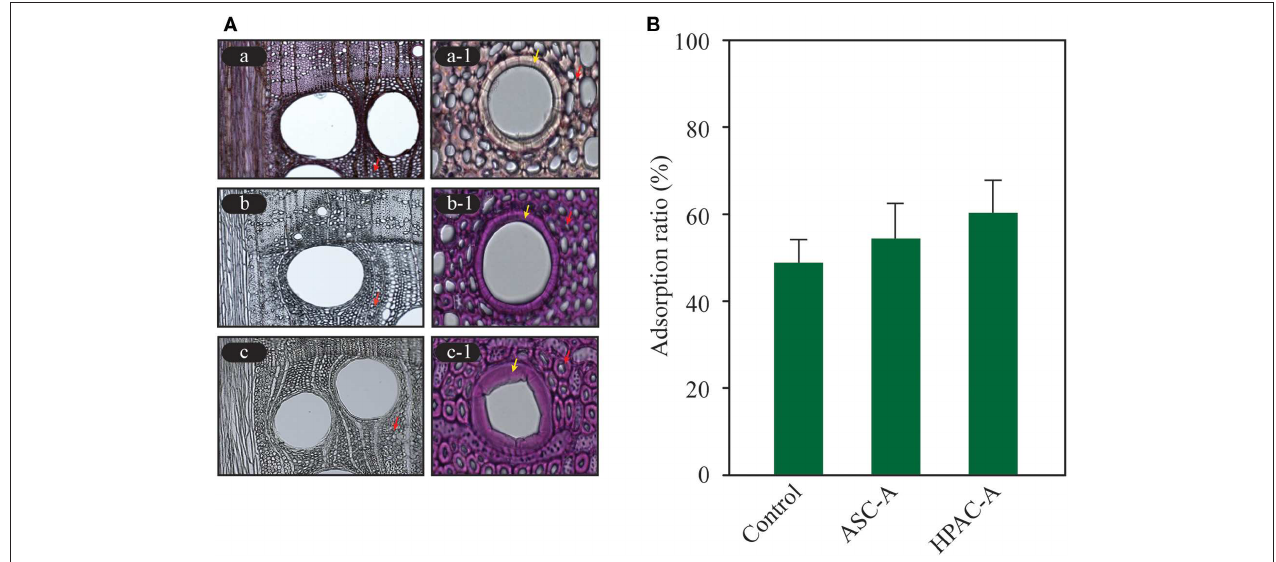
FIGURE 2 | Structural modification of cellulose. The modifications to ASC- and HPAC-pretreated oak and Avicel were determined using a light microscope and enzyme adsorption. (A) Significant cellulose swelling in the wood fibers (red arrow) and vessel elements (yellow arrow) was observed in the HPAC-pretreated oak compared with the ASC-pretreated oak. Lignin was not detected in b and c . a , control; b , ASC-pretreated; c , HPAC-pretreated. (B) Comparison of the cellulase adsorption. The control was Avicel that was not pretreated. ASC-A, ASC-treated Avicel; HPAC-A, HPAC-treated Avicel.